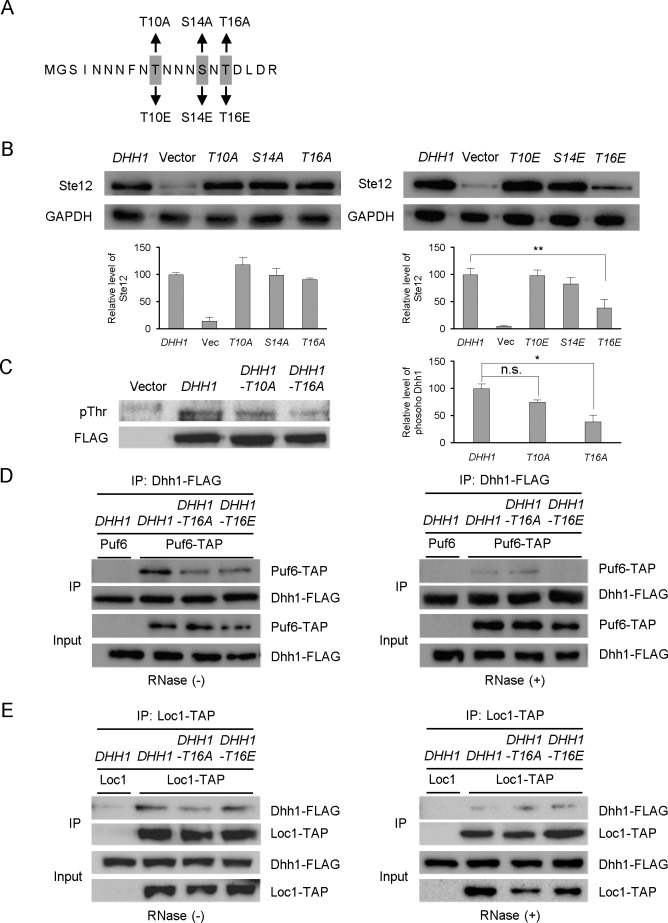
Effects of phosphorylation mutations of Dhh1 on Ste12 translation and Dhh1-Puf6 interactions.(A) Six mutations were introduced at the putative phosphorylation sites in the N-terminus of Dhh1. Mutated amino acids are indicated by gray boxes. (B) Ste12-HA protein levels in cells expressing various phosphorylation-mutant versions of Dhh1, as revealed by Western blot analysis. Protein extracts were prepared from the dhh1 deletion strain (JK400) carrying a DHH1 plasmid (pJI323), vector (pRS316), or mutant plasmid (pJI324-329). GAPDH was detected as a loading control. Graphs represent quantification of Ste12-HA to GAPDH ratio (n = 3 independent replicates). Values are mean ± SD. **p < 0.01. (C) Dhh1 phosphorylation was analyzed using an anti-phosphothreonine antibody. A wild-type BY4741 strain was transformed with DHH1-FLAG (pJI323), vector (pRS316), DHH1-T10A (pJI324), or DHH1-T16A (JI326) plasmids. Cell lysates were immunoprecipitated with anti-FLAG-conjugated agarose and probed with an anti-phosphor-threonine antibody. To detect Dhh1-FLAG, the membrane was re-probed with an anti-FLAG antibody. Graphs represent quantification of phosphorylated Dhh1 to Dhh1-FLAG ratio (n = 3 independent replicates). Values are mean ± SD. *p < 0.05. (D) Dhh1-Puf6 protein interactions, as revealed by co-immunoprecipitation analysis. Wild-type and PUF6-TAP were transformed with DHH1-FLAG (pJI330), DHH1-T16A (pJI331), or DHH1-T16E (pJI332). Cell lysates were immunoprecipitated with anti-FLAG-conjugated agarose in the absence (-) or presence (+) of RNase, and further probed with anti-PAP or anti-FLAG antibodies, respectively. (E) Dhh1-Loc1 protein interactions, as revealed by co-immunoprecipitation analysis. Wild-type and LOC1-TAP were transformed with DHH1-FLAG (pJI330), DHH1-T16A (pJI331), or DHH1-T16E (pJI332). Cell lysates were immunoprecipitated with anti-PAP-conjugated agarose in the absence (-) or presence (+) of RNase, and further probed with anti-PAP or anti-FLAG antibodies, respectively.